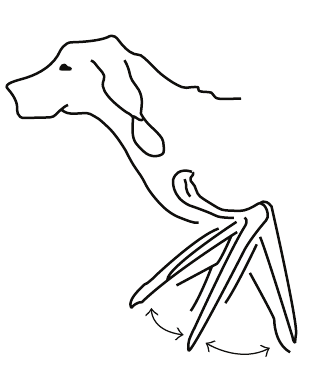
Figure 2: Movements of dog’s